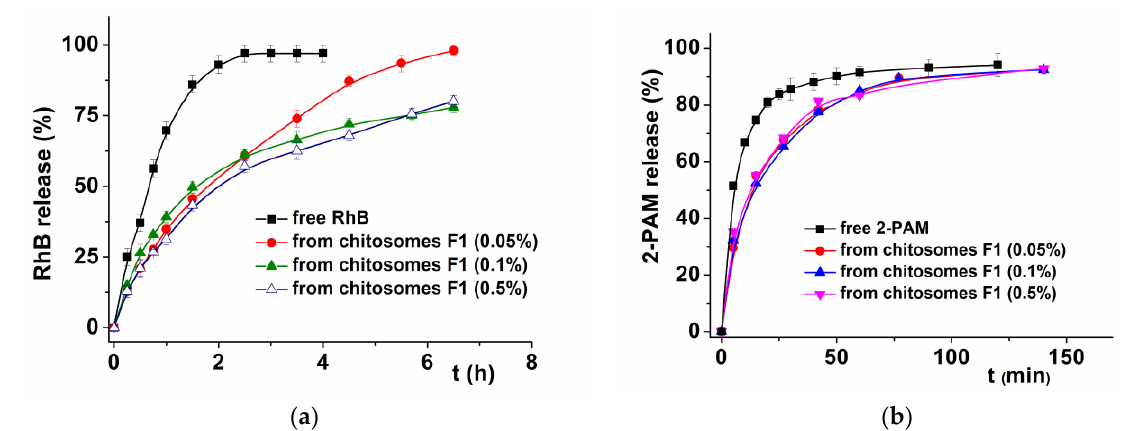
Figure 6. RhB ( a ) and 2-PAM ( b ) release curves in vitro from F1 chitosomes at different Cs concen- trations; phosphate buffer (0.025 M), pH = 7.4, 37 °C.